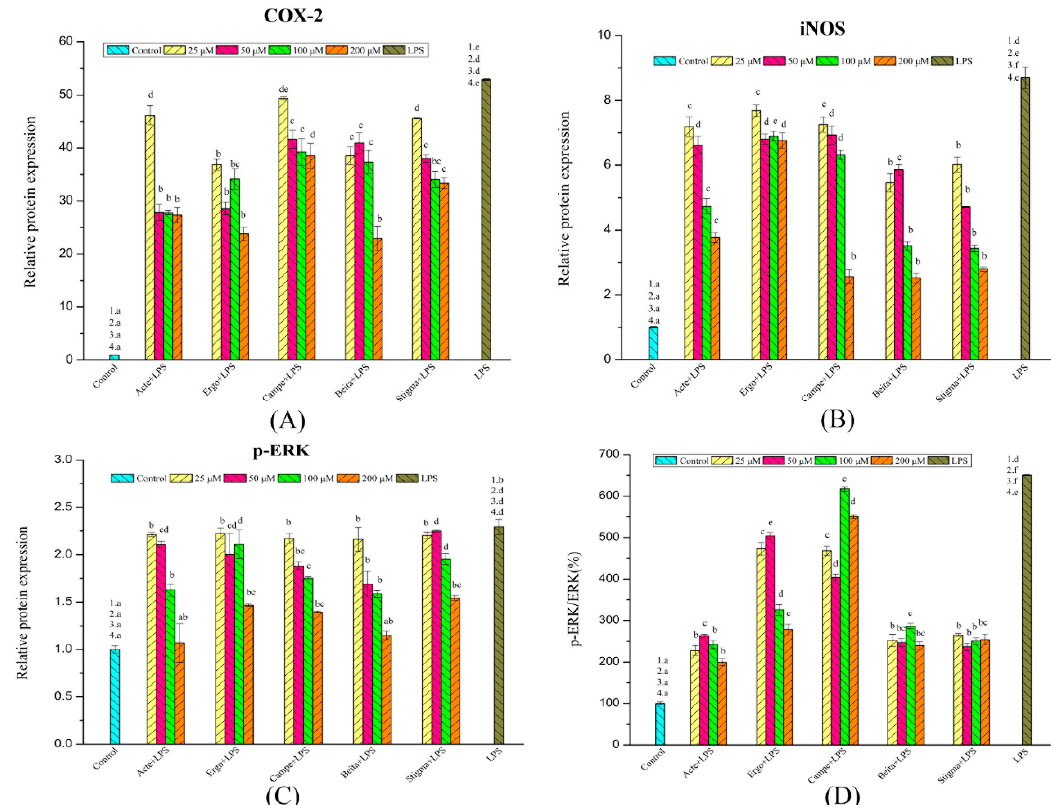
Figure 6. Effects of phytosterols on the expression of inflammatory regulators ( A ) COX-2, ( B ) iNOS, ( C ) p-ERK, and ( D ) p-ERK/ERK. Acte (ergosterol acetate); Ergo (ergosterol); Campe (campesterol); Beita ( β -sitosterol); Stigma (stigmasterol). The data are expressed as means ± SEM; different superscript letters for columns at the same concentration denote a significant difference ( p < 0.05); the numbers describe that the control/model group was compared with the experimental group at the concentrations of 25 (1), 50 (2), 100 (3), and 200 (4) μ M.